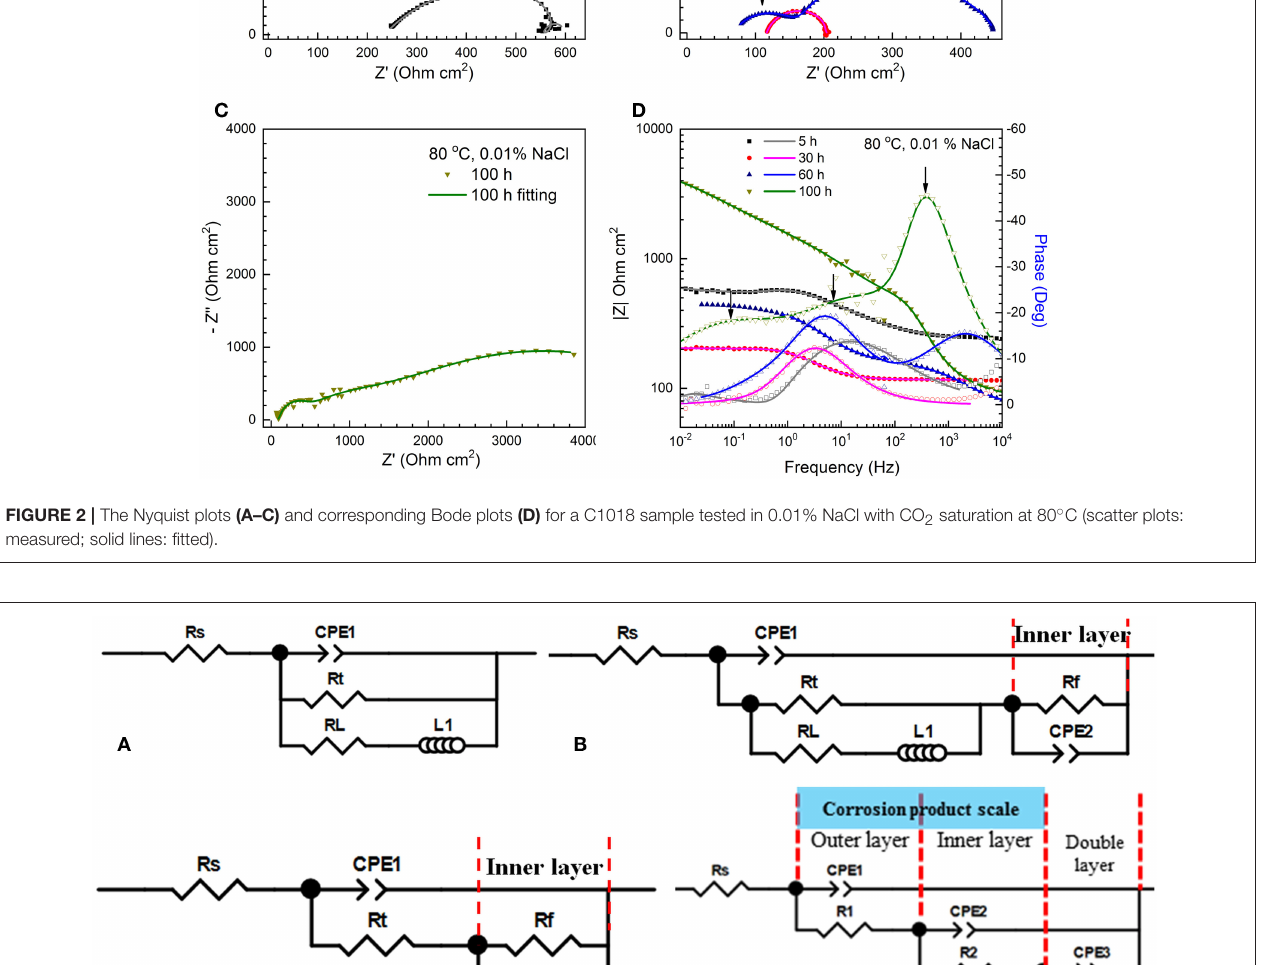
Figure 4B . The true polarization resistance ( R LPR ) was obtained P by subtracting the solution resistance ( R s by EIS results) from the apparent polarization resistance ( R app ), and then converted P to corrosion rates. The evolution of polarization resistance ( R P ) is compared at different temperature levels in 1% NaCl ( Figure 5A ) and different salt concentrations at 80 ◦ C ( Figure 5B ). It is